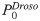
The mean horizontal correlation coefficient 〈Rh〉 diagram for a set of situations mimicking various fly eyes according to Eq 9 in S1 Text.The left half of the main diagram corresponds to β < 0 (Eq 5) while the right half corresponds to β > 0 (Eq 6). The horizontal axis shows the value of α which varies from 0 to 1 to the right and left of the y-axis. The vertical axis indicates the value of P0Droso. The chromatic pink indicates 〈Rh〉 = −1, while the gray pixels show 〈Rh〉 = 0. Some examples of the simulated eye configurations are shown (panels (A)-(I)) for the following parameter values: (A) β > 0, α = 1. A value of β > 0 (Eq 6) indicates the Doli striped region, α = 1 makes the second term ((1-α)pjDroso(S|X))on the right hand side of Eq 6 vanish, so that it becomes independent of P0Droso. We thus have a pure Doli configuration. (B) β > 0, α = 0.9 and P0Droso=0.4. This configuration deviates slightly from a perfect Doli eye by introducing some randomness via the Drosophila component. (C) β > 0, α = 0.65 and P0 = 0.9. As the value of α is reduced, the effect of the ordered Doli wanes, giving way to patterns that more closely resemble Drosophila. (D) β > 0, α = 0.65 and P0 = 0.1 Here we see Drosophila-like patterns, where the spatial distributions are random, although the ratio of the two colors is fixed. (E) α nearly zero, P0Droso=0.1 and (F) α nearly zero, P0Droso=0.9: In both cases, a Drosophila dominant behavior is observed, with the different percentages of reds and greens corresponding to the different values of P0Droso. Note that for β < 0, i.e. the left half of the phase diagram, the effect of the so-called Uniform Fly increases as α increases at the expense of the Drosophila effect. The extreme case of this is at α = 1 when the configurations are a homogeneous green (or red). (G), (H) and (I): α = 0.9. with P0Droso=0.9 (G), P0Droso=0.55 (I) and P0Droso=0.1 (H). The dominant behaviour is that of the Uniform Fly, which gives rise to a nearly uniform green(red) color. As P0Droso increases, red gives way increasingly to green.